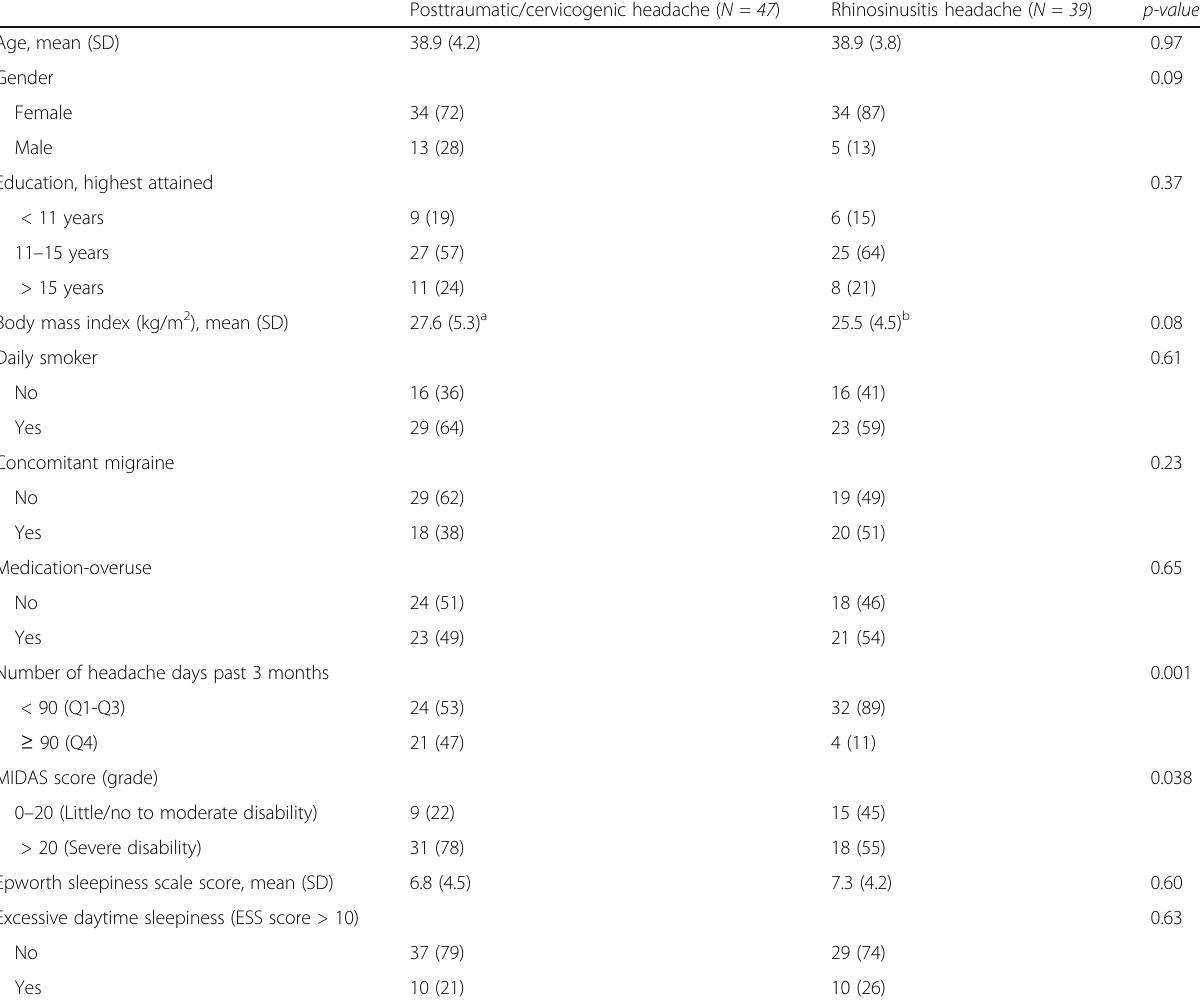
Table 3 Descriptive statistics for respondents with chronic posttraumatic headache/cervicogenic headache vs. headache attributed to chronic rhinosinusitis. Number (%) unless stated